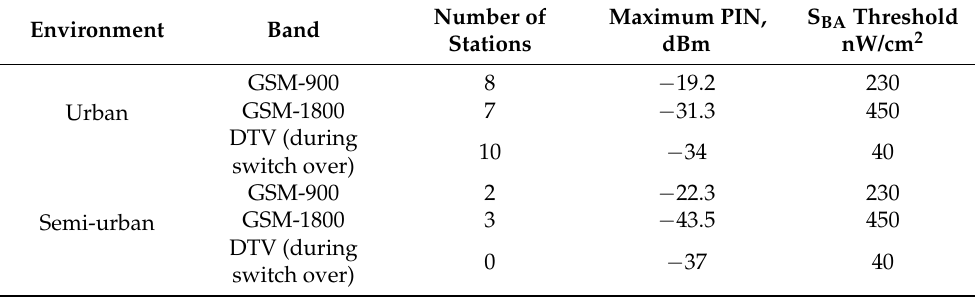
Table 1. Summarizes the RF measurements in urban, semiurban, and rural areas